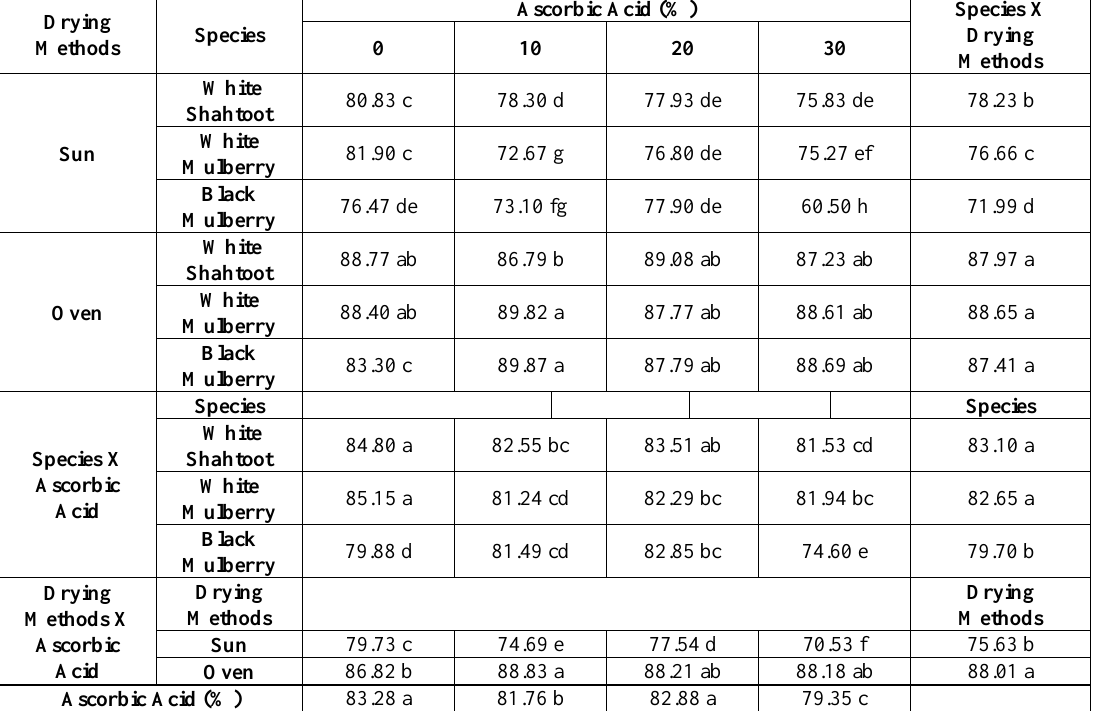
Table 2. Effect of ascorbic acid concentrations and drying methods and their interactions on total solids content (%) of three mulberry